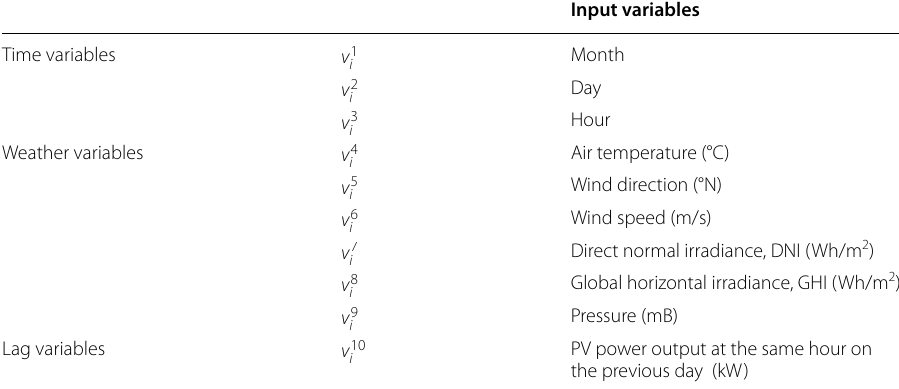
Table 1 List of input variables used to forecast PV power